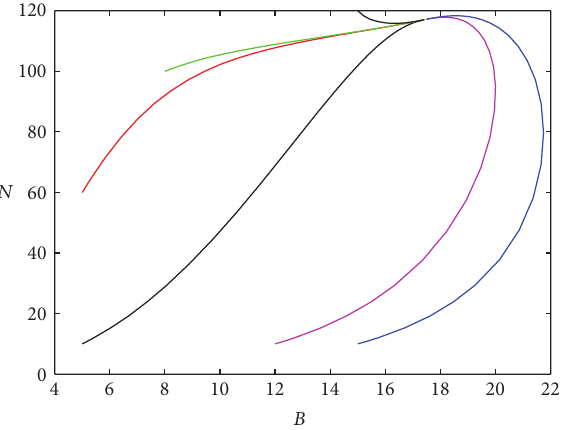
F 2: Global stability of